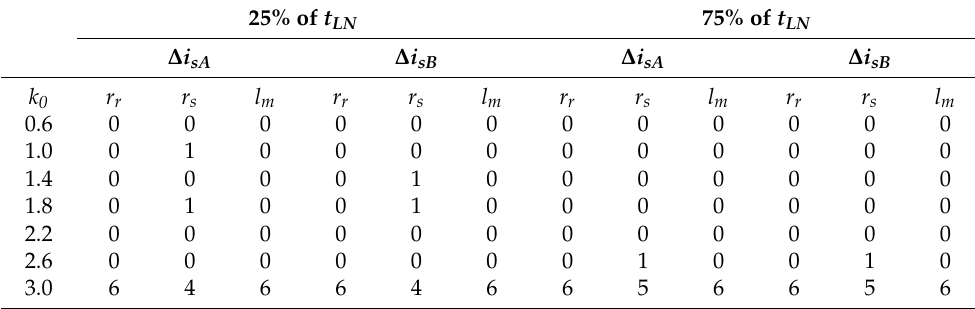
Table 1. The number of smallest RMSE values for individual k 0 .